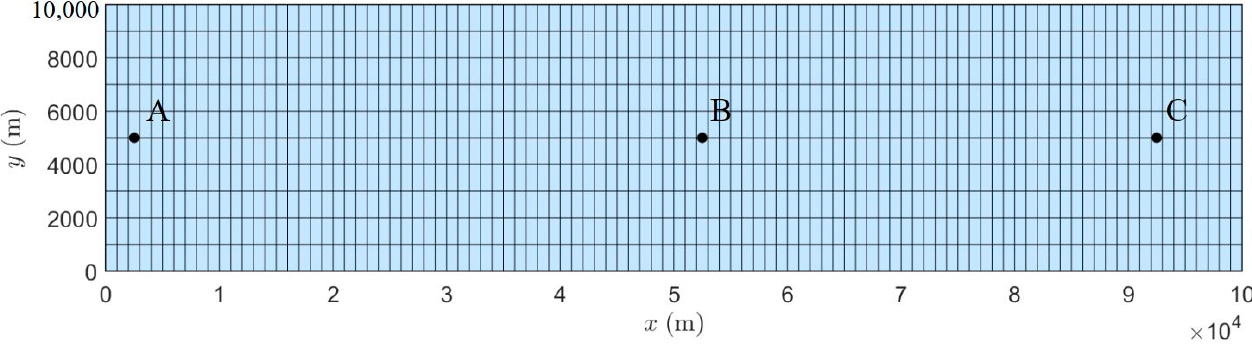
Figure 3. Location of the gauge points and sketch of the two-dimensional computational domain. According to Neuman and Pierson [40], the analytical solution of the surface elevation η , the horizontal velocities u and v , and the vertical velocity w at a point P( x , y , z ) at time